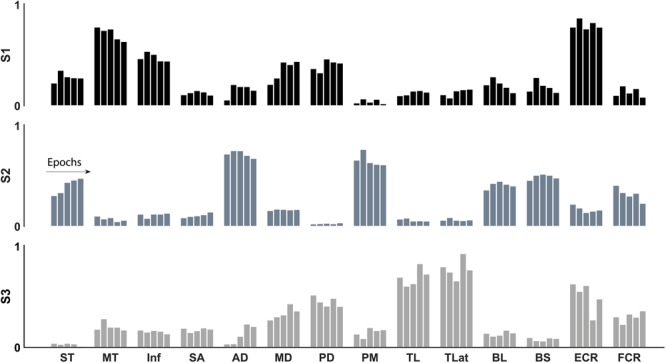
Synergy structure (weights) through the development of fatigue of the three identified synergies: internal rotation (black), flexion (grey), and extension (light grey). The structure of the three synergies was conserved with the development of fatigue.